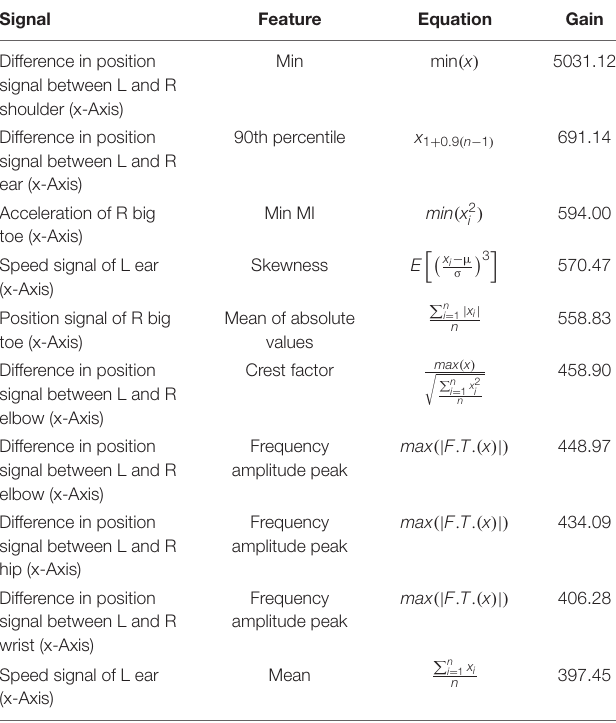
TABLE 3 | Feature importance for the motion recognition model based on the XGBoost gain (top 10).